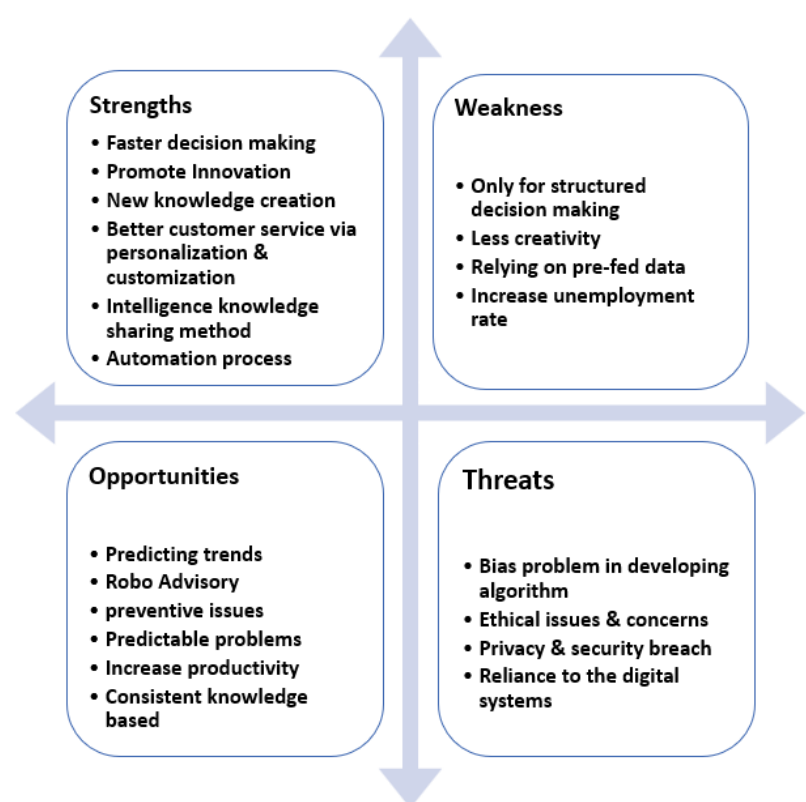
Figure 5. SWOT Analysis for “machine learning” AND “knowledge management” .